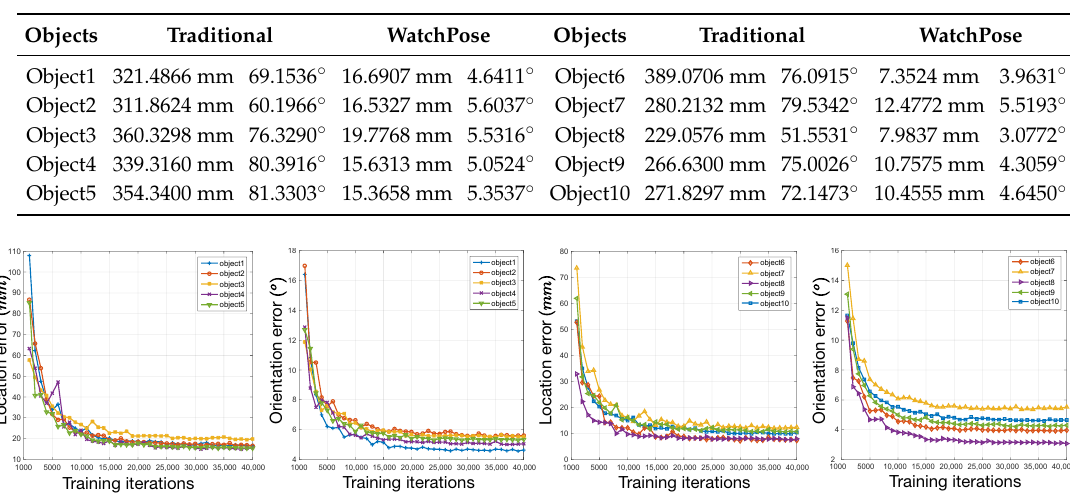
Table 4. Estimated camera location (mm) and orientation ( ◦ ) errors of each object using models trained on the augmented Industrial10-WatchPose and Industrial10-Traditional.